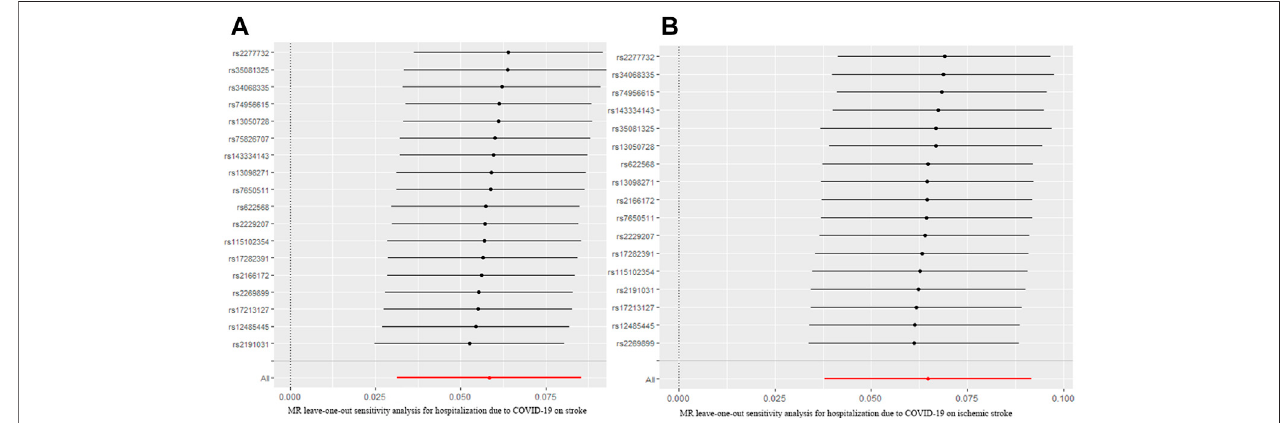
FIGURE 4 | MR leave-one-out sensitivity analysis for hospitalization due to COVID-19 on stroke (A) and ischemic stroke (B) . MR, Mendelian randomization.